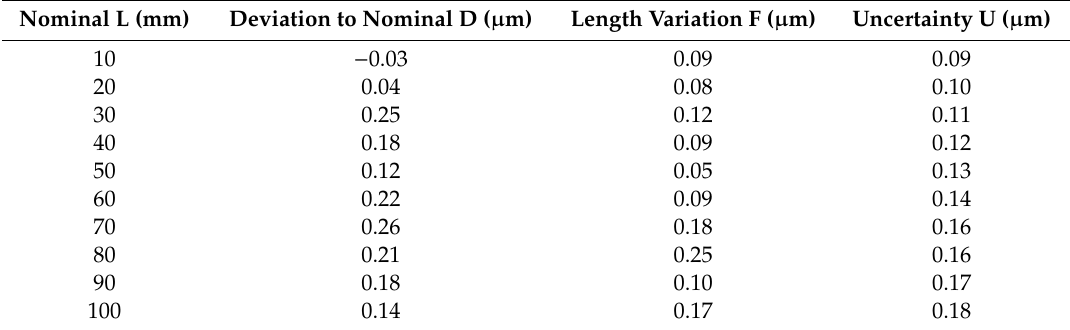
Table 1. Block characteristics, such as nominal value, deviation, and